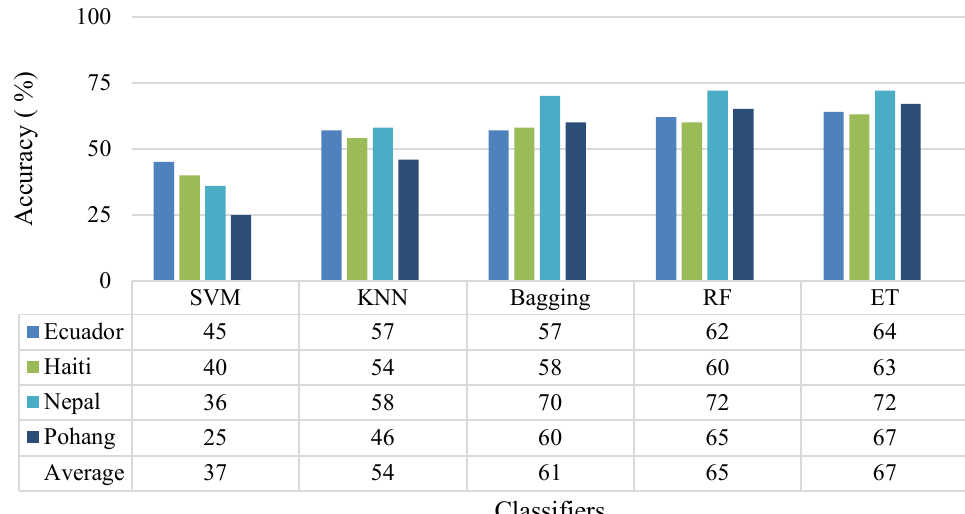
Figure 9. The chart involves the predictive accuracy acquired by each candidate classifier against every dataset.